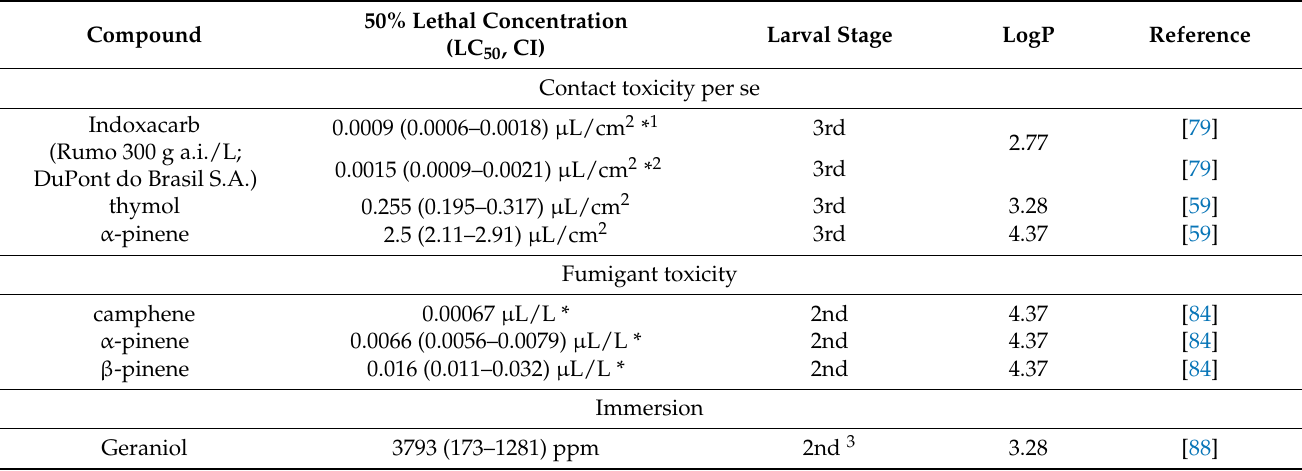
Table 10. Lethal effects of pure compounds tested, on Spodoptera frugiperda , by contact toxicity, fumigant and immersion methods.